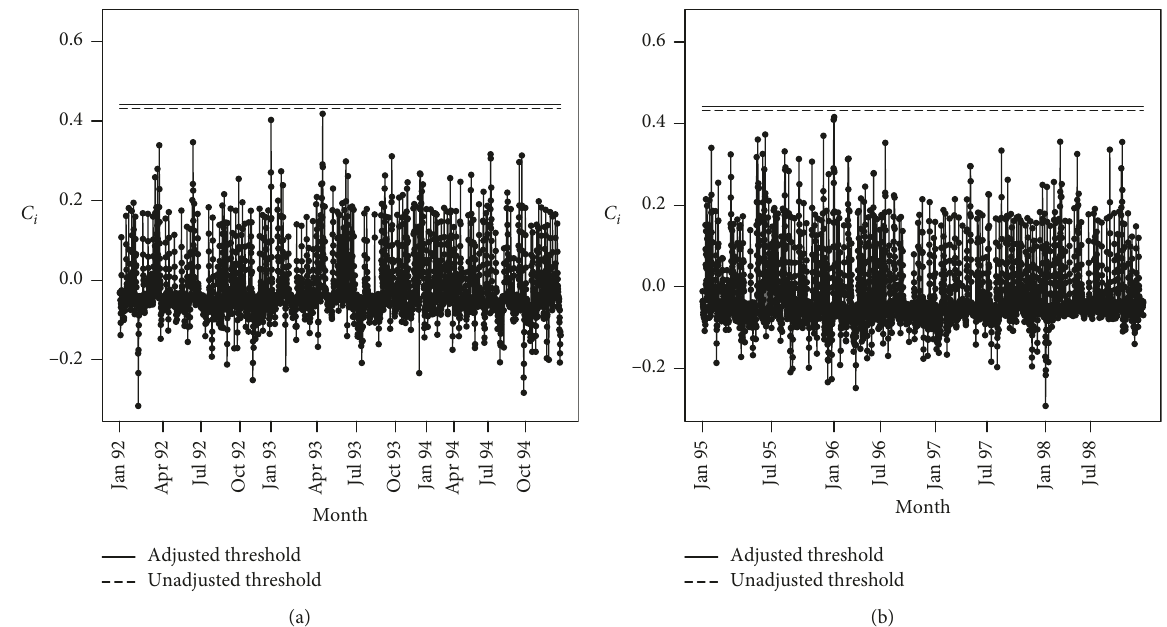
Figure 13: RA-EWMA chart for Phase-I and Phase-II assuming first three years as the Phase-I for 30 days mortality of cardiac surgery patients. (a) Phase-I chart, unadjusted UCL � 0.4314 and adjusted UCL � 0.4421. (b) Phase-II chart, unadjusted UCL � 0.4314 and adjusted UCL �